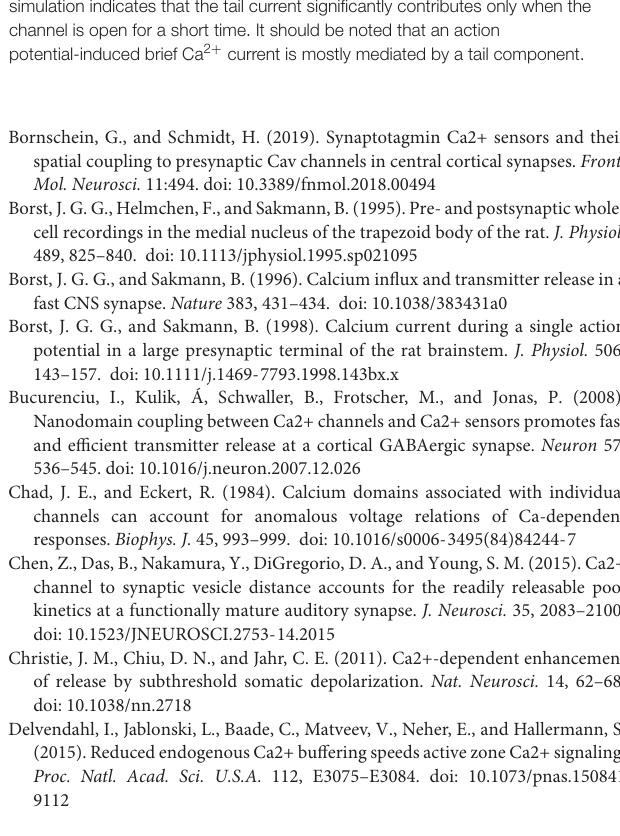
FIGURE S1 | The effect of tail Ca 2 + currents on [Ca 2 + ] i and release simulations. (A) Top, Ca 2 + current waveforms used in this simulation consisted of steady step current (0.15 pA) and subsequent tail current. Durations of step currents varied from 0.5 to 5 ms. The peak amplitude of the tail current was 0.3 pA, which decayed exponentially with the fast (0.2 ms, 90%) and slow (1.0 ms, 10%) time constants. Middle, [Ca 2 + ] i transients at a 20 nm distance in the control (0.2 mM ATP and EFB, solid line) and in the presence of 10 mM EGTA (dashed line). The tail current additionally increased [Ca 2 + ] i upon the steady-state [Ca 2 + ] i induced by the preceding step current. Bottom, cumulative release probability. Pv increased with the duration of the step. (B) Spatial profiles of Pvs evoked using Ca 2 + current with tail current in the control and in the presence of EGTA. (C) Spatial profiles of the inhibitory effect of EGTA on release. Spatial profile shifted with the increase in step duration. (D–F) Same as (A–C) but without tail current. When the duration of step component was sufficiently long (e.g., 5 ms, red traces), the spatial profiles of Pv (B,E) and the effect of EGTA on release (C,F) showed similar distributions, because Pv and the effect of EGTA were exclusively determined by the [Ca 2 + ] i increase during the step. By contrast, when the step duration was shorter (e.g., 0.5 ms, blue traces), the tail current additionally elevated Pv, and the effect of EGTA decreased. (G) For comparison, release rate traces under the control condition for 0.5 and 5 ms steps with/without tail current are shown. This simulation indicates that the tail current significantly contributes only when the channel is open for a short time. It should be noted that an action potential-induced brief Ca 2 + current is mostly mediated by a tail